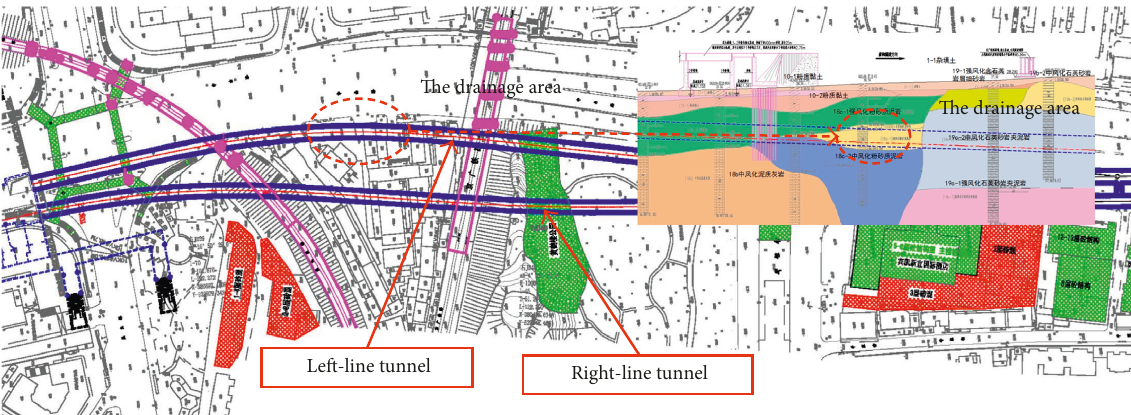
Figure 2: The water gushing section of XWS.